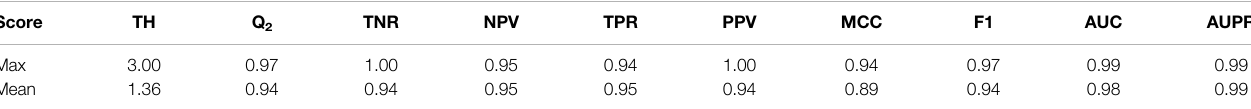
TABLE 1 | Optimized performance of ThermoScan based on the maximum (Max) and average (Mean) scores. The performance measures are de fi ned in Supplementary Materials . The standard deviation of all the performance measures are ≤ 0.01. Score TH Q 2 TNR NPV